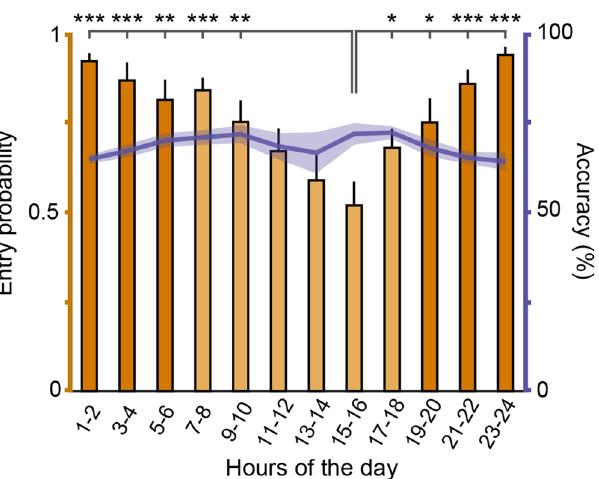
Figure 3. Mice were least active in the middle of the light phase but showed stable performance throughout the day. Activity (bar graphs, y axis on the left) was defined as the probability of mice engaging in a training session. Light phase (indicated by lighter colors) started at 7 am. Animals showed less activity in the afternoon (from 3 to 4 pm), but their accuracy (line plot, y axis on the right) was stable during the day. Bars and line plot show mean ± SEM. *, p < 0.05, ** p < 0.01, ***, p < 0.001, t-test; N =